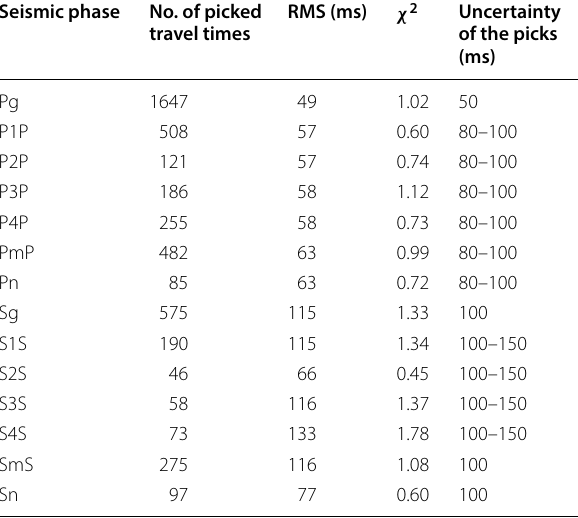
Table 1 RMS misfit and χ 2 values for individual seismic phases Seismic